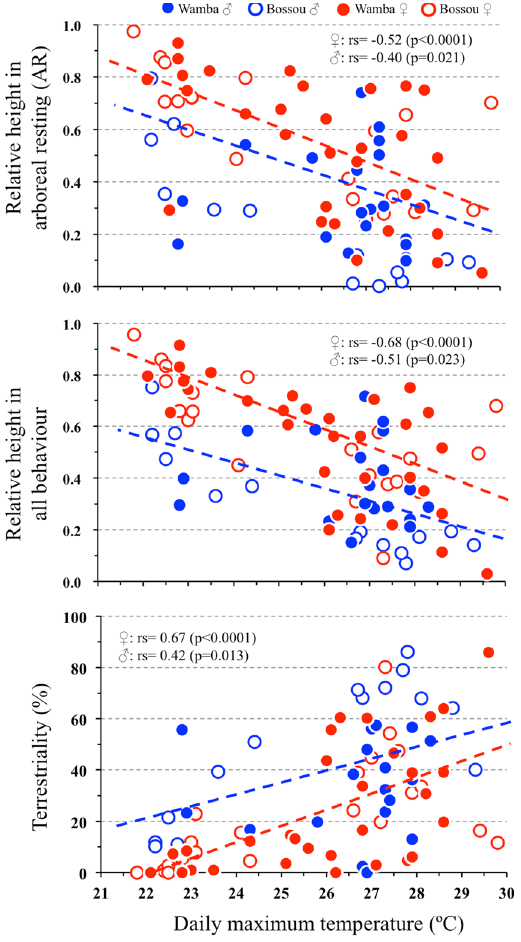
Figure3. Correlation between utilization height (upper, middle) or terrestriality (lower) and daily maximum ambient temperature according to